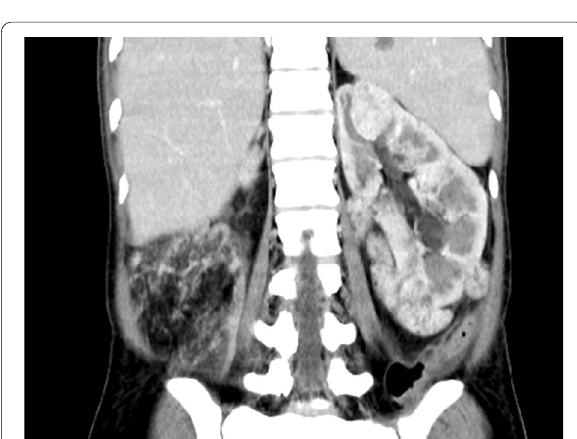
Fig. 6 Huge right-sided renal angiomyolipoma with a bleeding pseudoanurysm. Few hyperdense enhancing soft tissue densities were noted in the angiomyolipoma of the left kidney